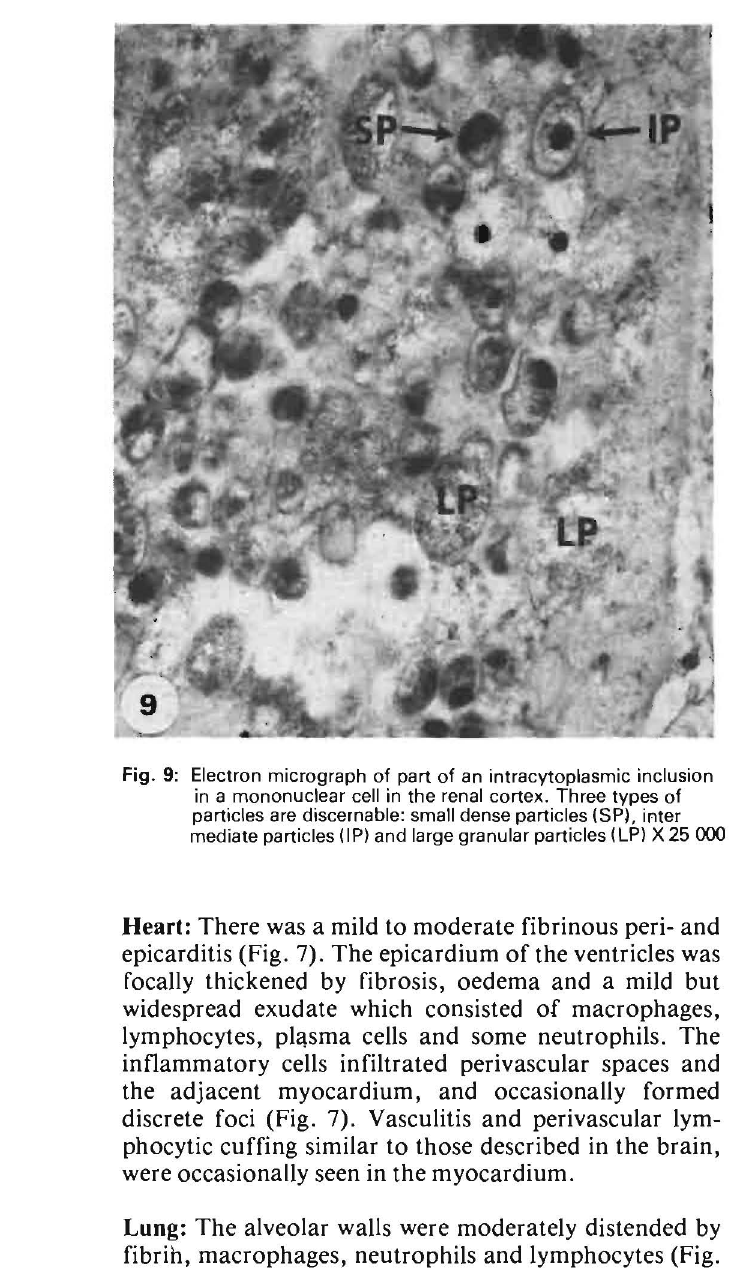
Heart: There was a mild to moderate fibrinous peri- and epicarditis (Fig. 7). The epicardium of the ventricles was focally thickened by fibrosis, oedema and a mild but widespread exudate which consisted of macrophages, lymphocytes, pl&sma cells and some neutrophils. The inflammatory cells infiltrated perivascular spaces and the adjacent myocardium, and occasionally formed discrete foci (Fig. 7). Vasculitis and perivascular lym phocytic cuffing similar to those described in the brain, were occasionally seen in the